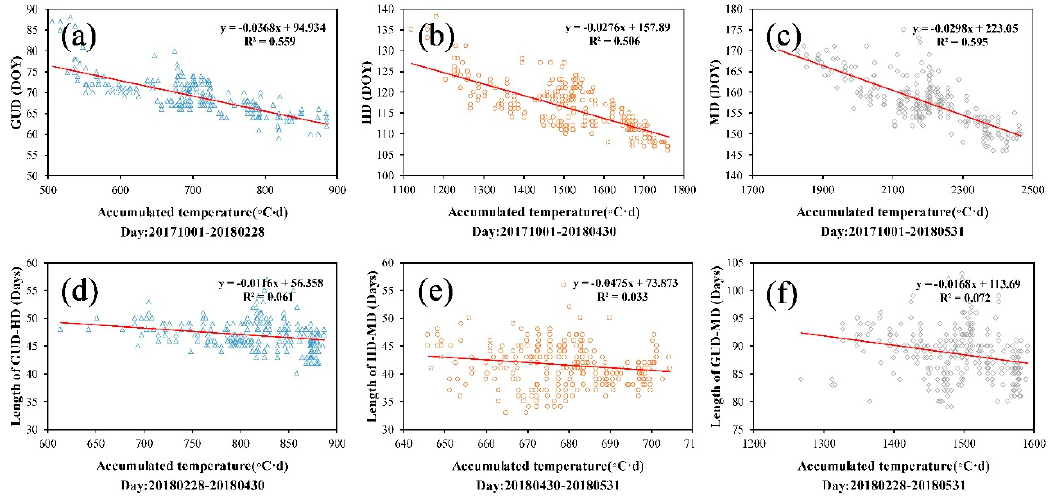
Figure 12. The relationships between accumulated temperature and winter-wheat phenology. The horizontal axes represent the accumulated temperature of the corresponding days, and the vertical axes represent the main phenological phases, namely ( a ) GUD, ( b ) HD, and ( c ) MD, and the lengths of time between the phenological phases, namely, ( d ) between GUD and HD, ( e ) between HD and MD, and ( f ) between GUD and MD.